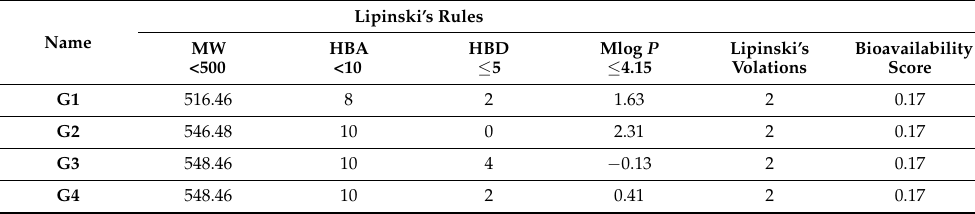
Table 2. Physico-chemical properties of the synthesized compounds in terms of the drug likeness and the bioavailability